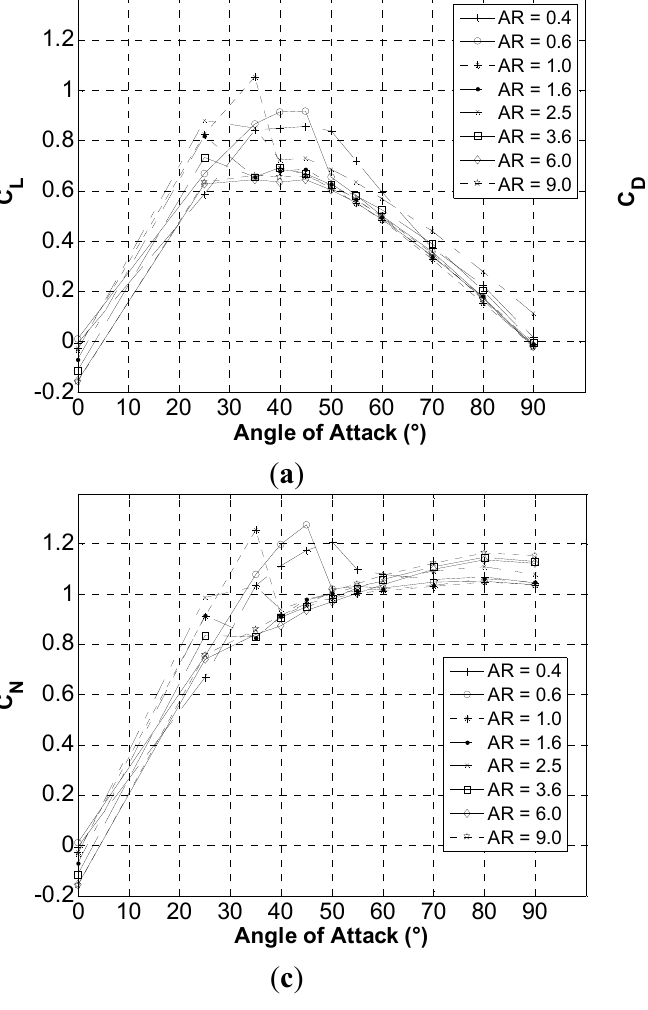
Figure 4. ( a ) Free-stream lift; ( b ) drag; and ( c ) normal force coefficient, as a function of AR and α